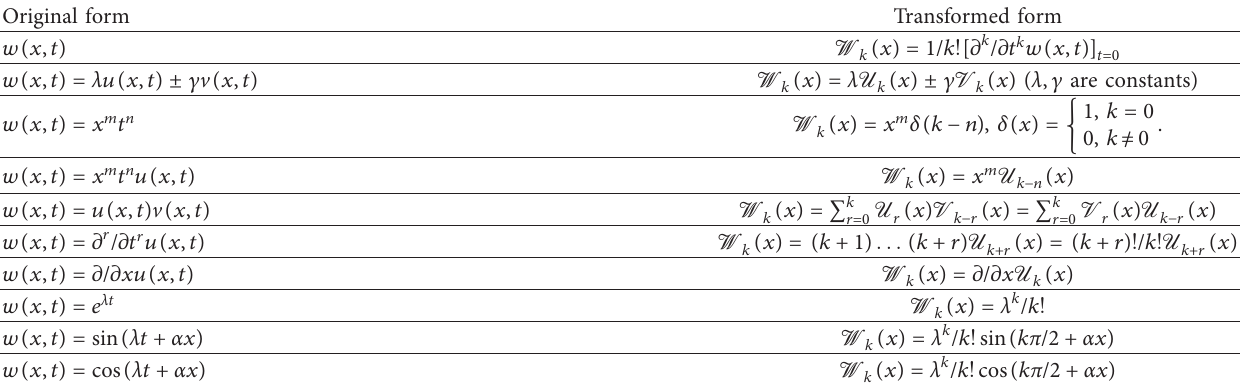
Table 1: The fundamental operations of